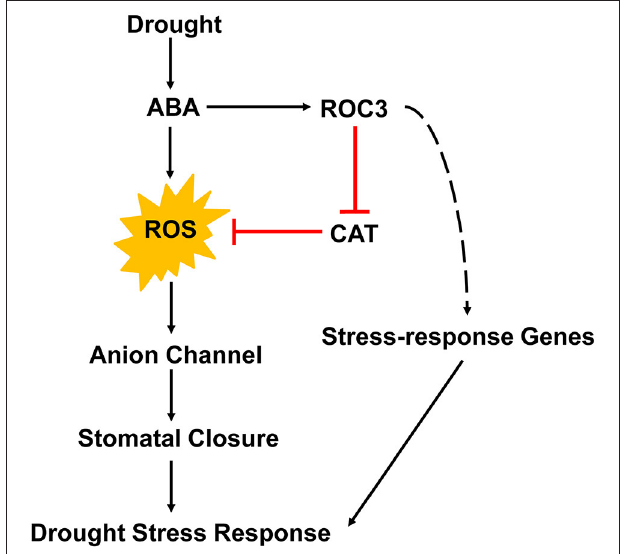
FIGURE 8 | A proposed working model for the role of ROC3 in the regulation of stomatal movement and the drought stress response of A. thaliana .